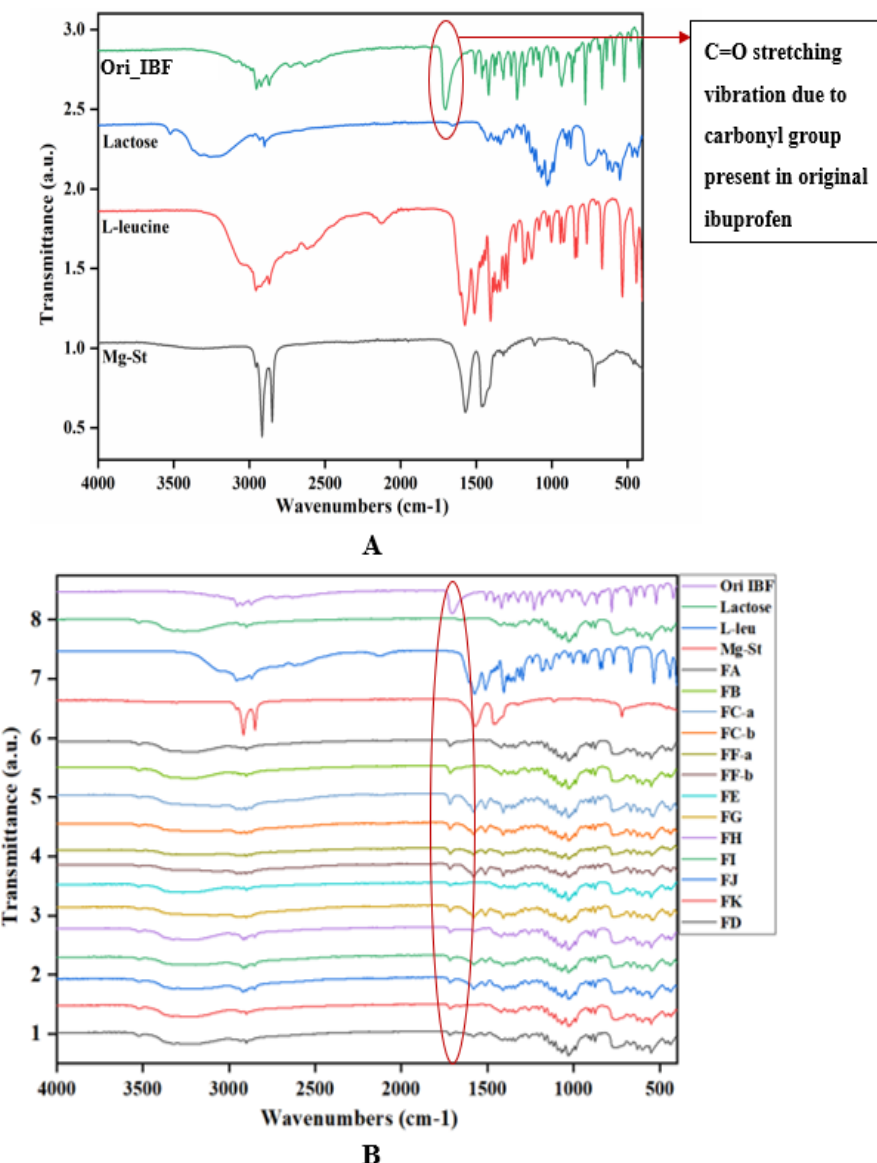
Figure 3. ( A ) Individual FTIR spectra of original ibuprofen, lactose, leucine and MgSt. ( B ) Subtracted FTIR spectra of prepared DPI formulation powder mixtures.